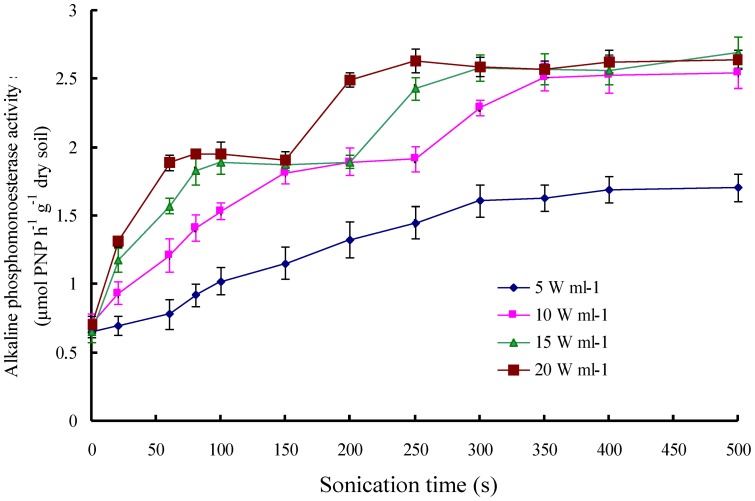
Activity of alkaline phosphatase of the field-moist soil as a function of sonication time. Data are means ± SD (n  =  3).